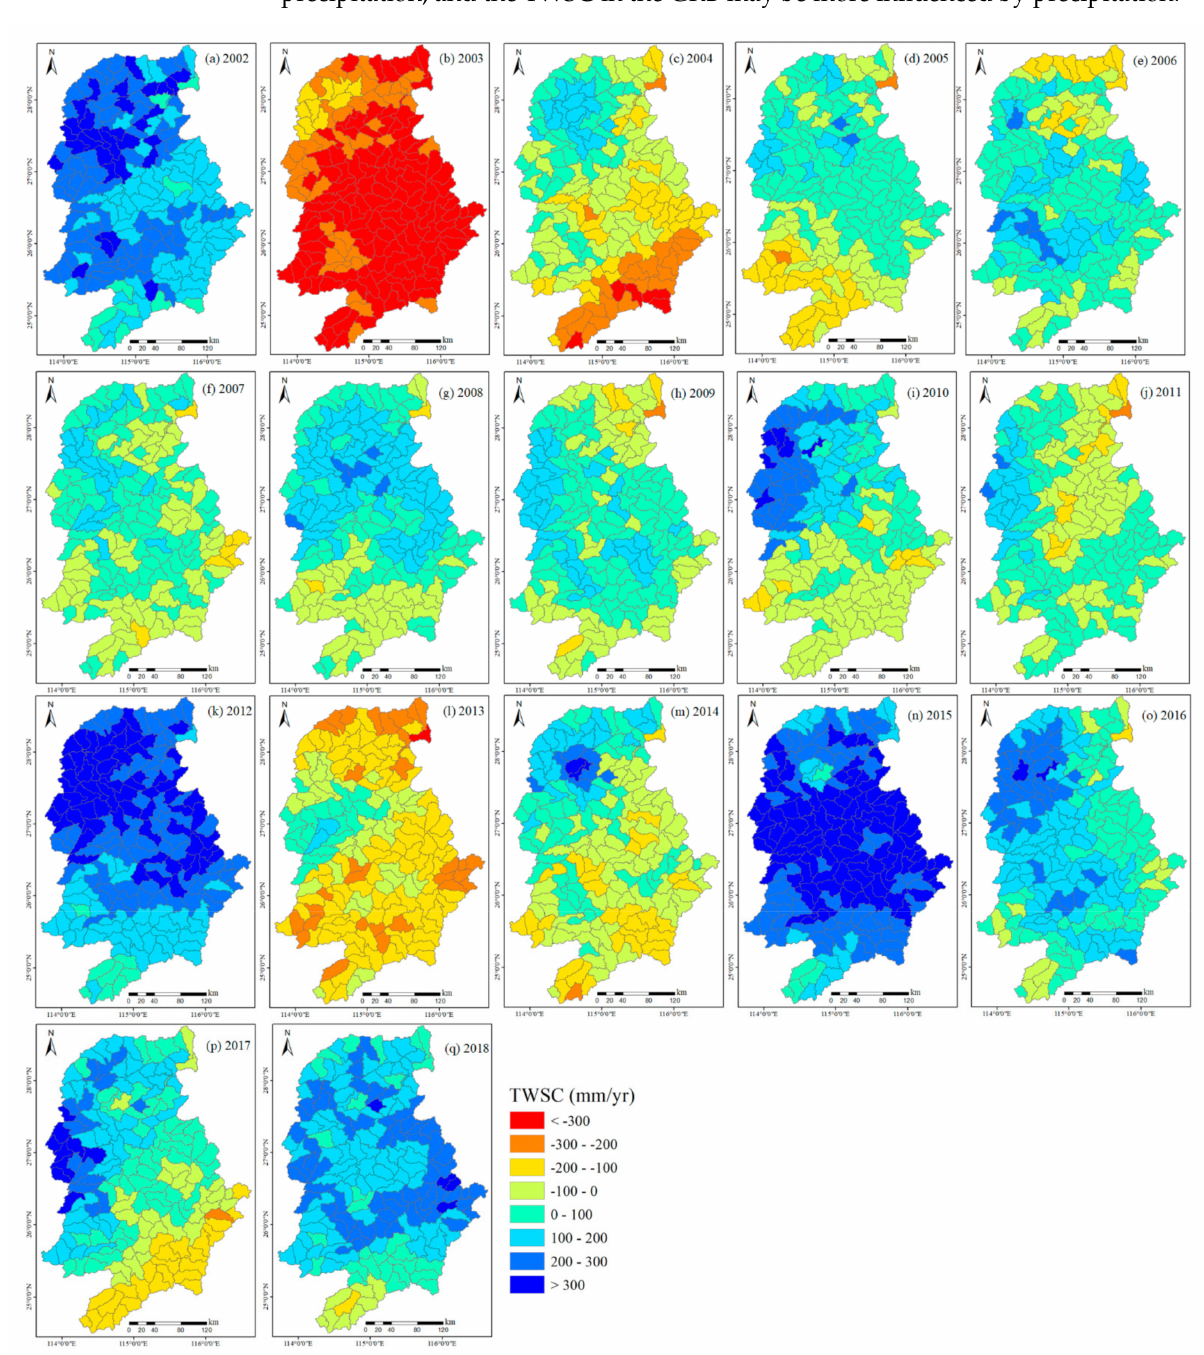
Figure 9. Spatial distribution in annual TWSC in the Ganjiang River Basin from 2002 to 2018 ( a – q ). The time series of annual TWSC in the 172 sub-basins from 2002 to 2018 is shown in Figure 4g. According to the TWSC of 172 sub-basins in different years, it can be seen that the TWSC in most sub-basins show a relatively consistent fluctuation during the study period. TWSC decreases most in 2003, there are obvious increases in 2012 and 2015, and all sub-basins in 2012 and 2015 present positive values in TWSC. Figure 4h shows that in most sub-basins of the GRB, the interannual variation in TWSC is consistent. The monthly